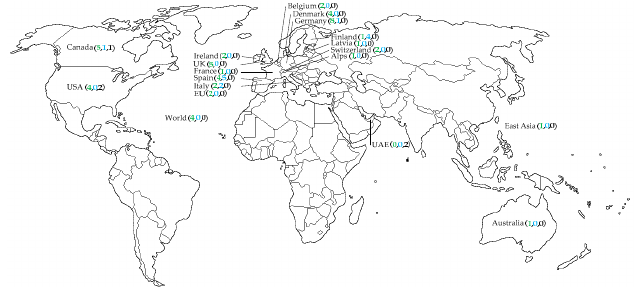
Figure 3. Geographical overview of regional/national-scale, distributed-scale, and nuclear-assisted PtG deployments compiled in Tables 1–3. The values in parentheses (X, Y, Z) indicate the number of regional/national, distributed and nuclear-assisted published PtG deployment studies, respectively, for a given geographical region.